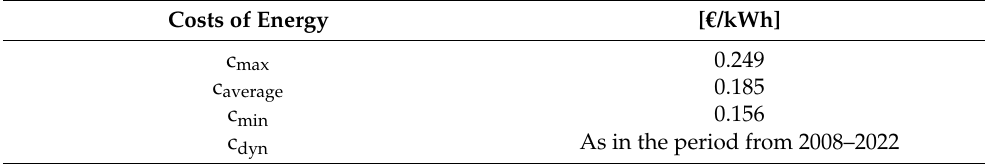
Figure 7. Historical series with electricity costs in Italy between 2008 and 2022. S1 = the first semester of the year (January to June) and S2 = the second semester of the year (July to December). Table 4 shows the energy costs considered in the present study. Table 4. Costs of energy considered in the study.